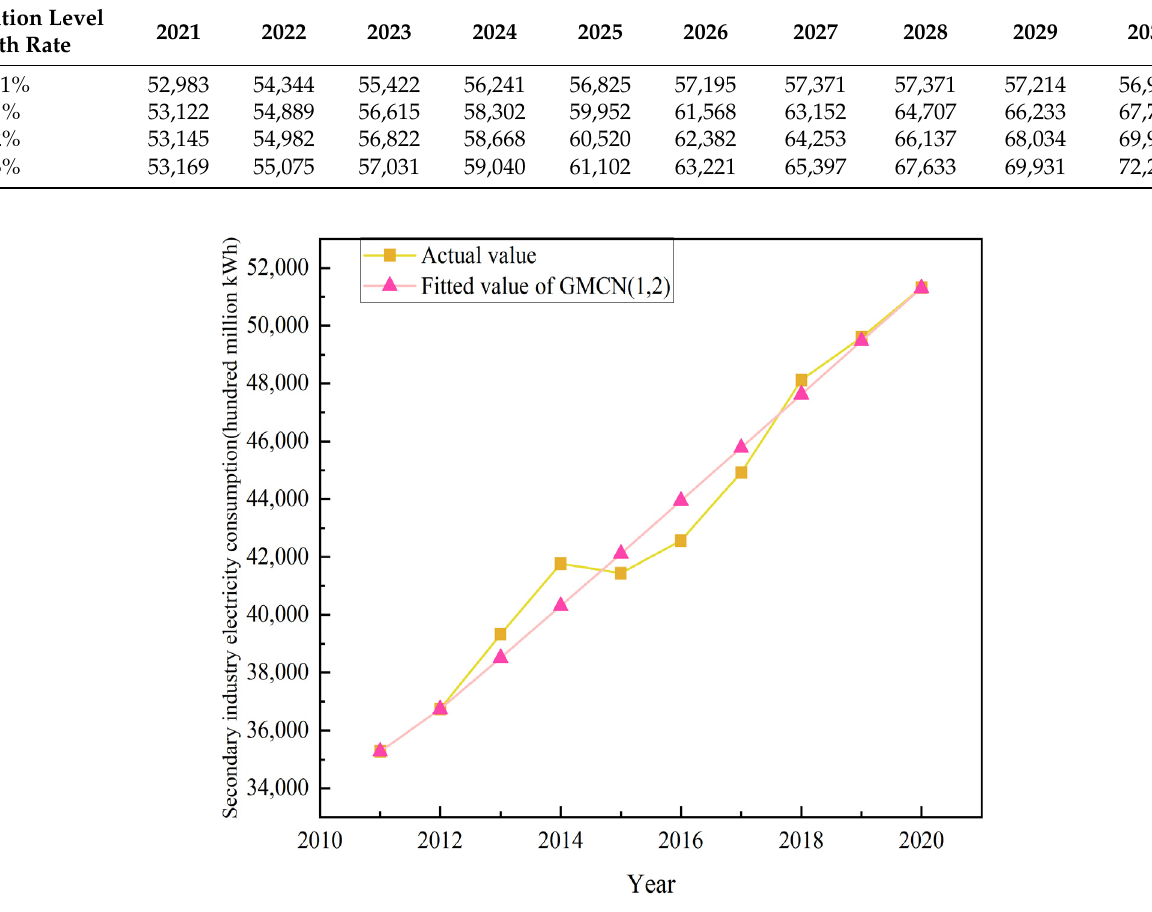
Figure 4. Fitting between predicted and actual values.